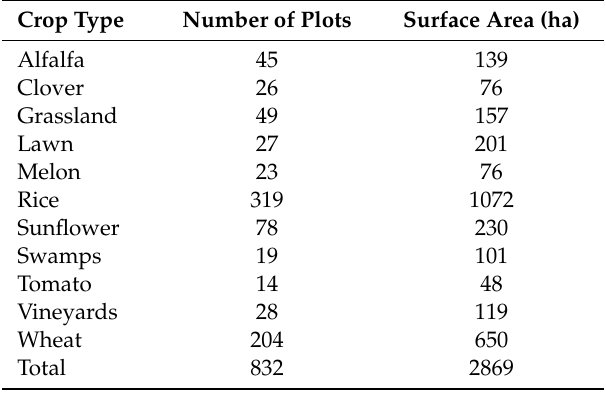
Table 1. Distribution of the reference plots per class of land Table 1: Distribution of the reference plots per class of land cover.